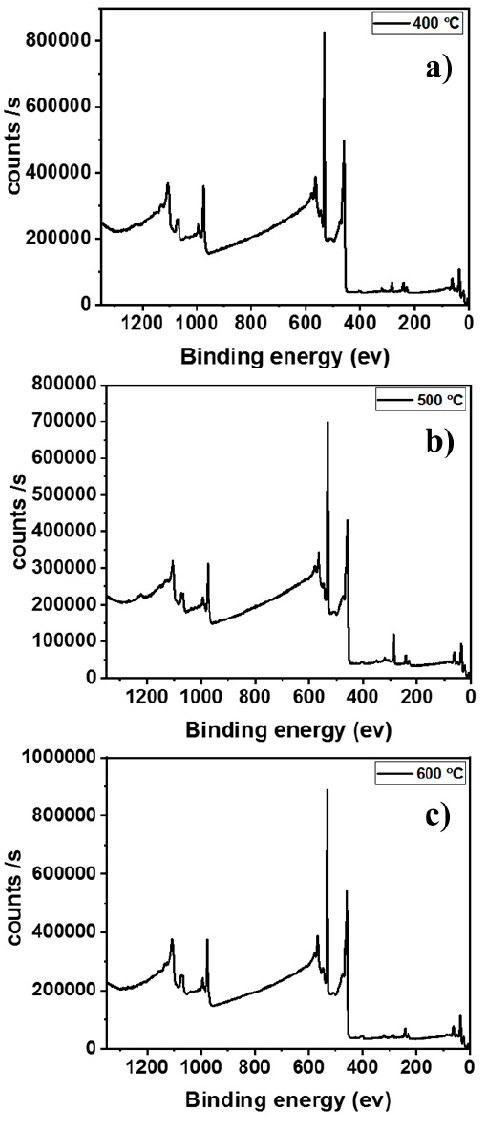
Figure 3. X-ray photoelectron spectroscopy (XPS) survey spectra of TiO 2 thin-films post-annealed at di ff erent temperatures. ( a ) TiO 2 thin-films post-annealed at 400 ◦ C; ( b ) TiO 2 thin-films post-annealed at 500 ◦ C; ( c ) TiO 2 thin-films post-annealed at 600 ◦